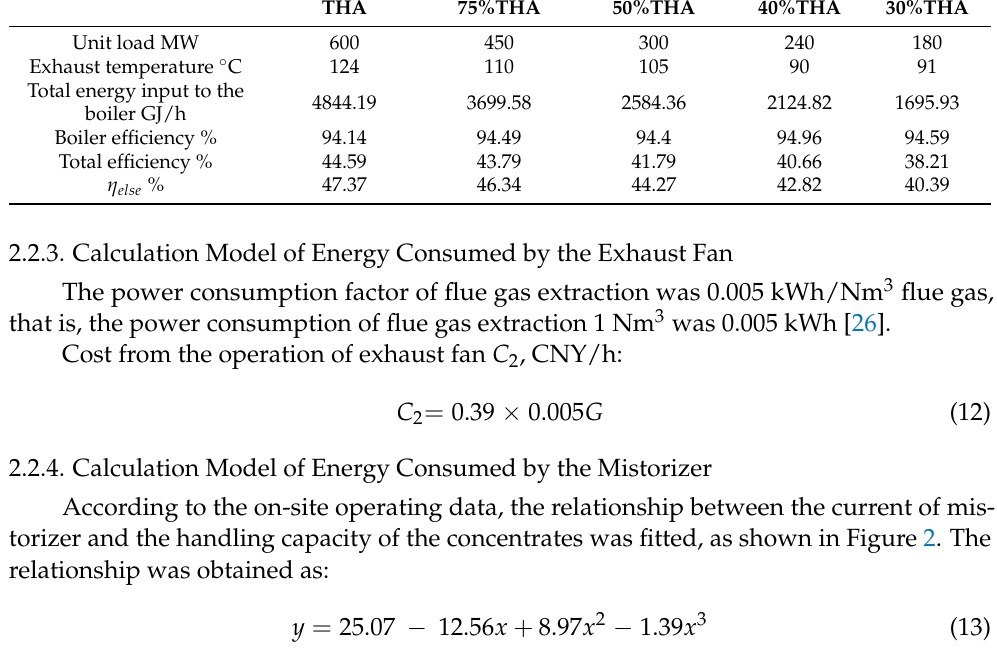
Table 1. Unit parameters under different loads before flue gas extraction.